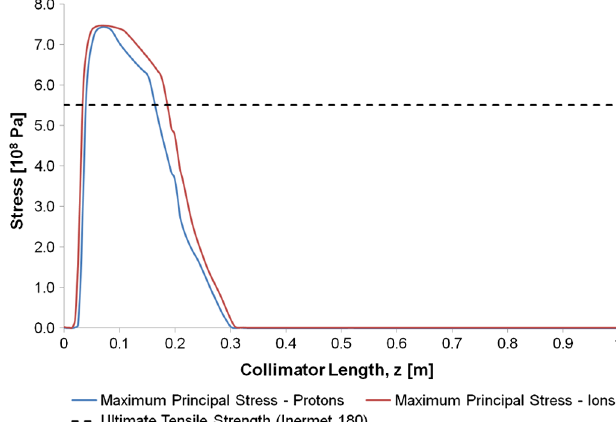
FIG. 18. Comparison of the maximum principal stress on the collimator jaw assembly for the proton and ion beam impacts. For each case, the maximum principal stress is plotted along Path AB shown in Fig. 17.